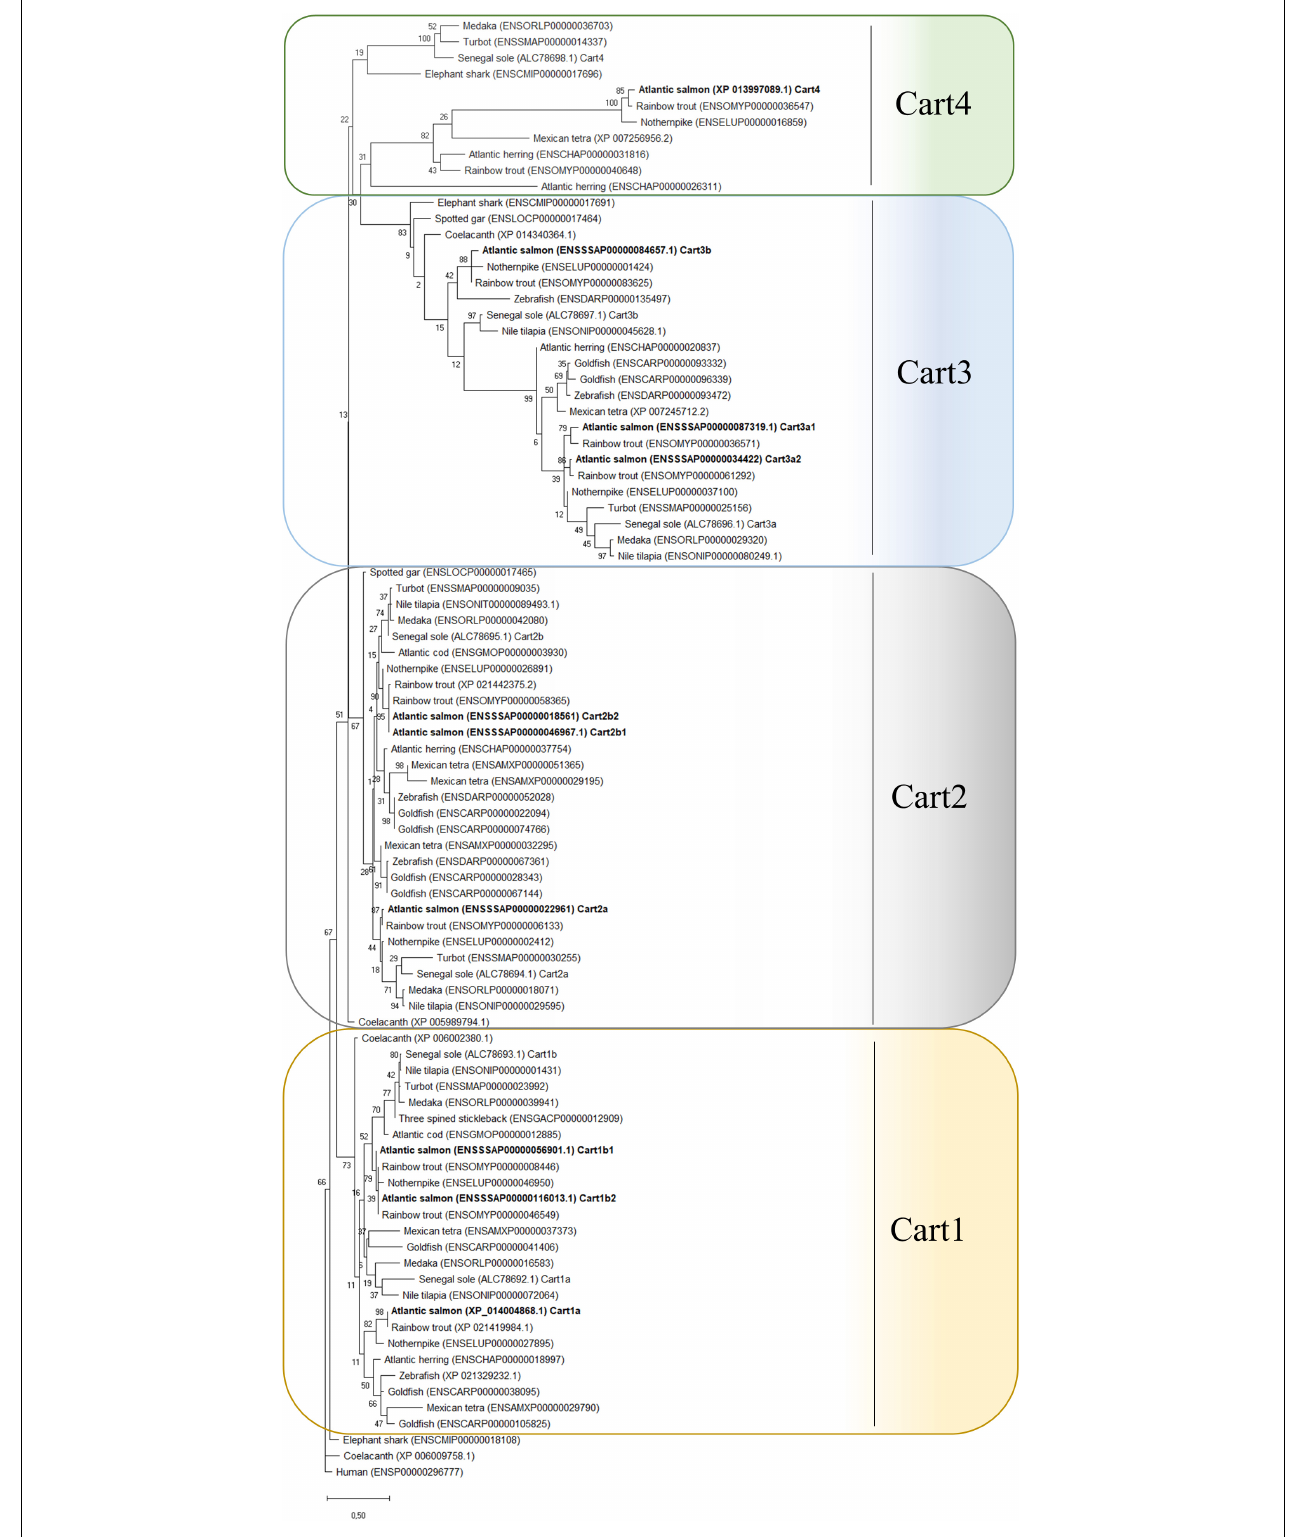
FIGURE 3 | Phylogenetic analyses of Atlantic salmon Cart and other fish species and human based on the predicted mature peptide sequences. The evolutionary history was constructed by using the Maximum Likelihood method, 500 bootstraps replicates and JTT + G matrix-based model in MEGA X. The tree with the highest log likelihood (–4018, 51) is shown. The percentage of trees in which the associated taxa clustered together is shown next to the branches. The tree is drawn to scale, with branch lengths measured in the number of substitutions per site. This analysis involved 91 amino acid sequences. The tree is rooted to human CART.